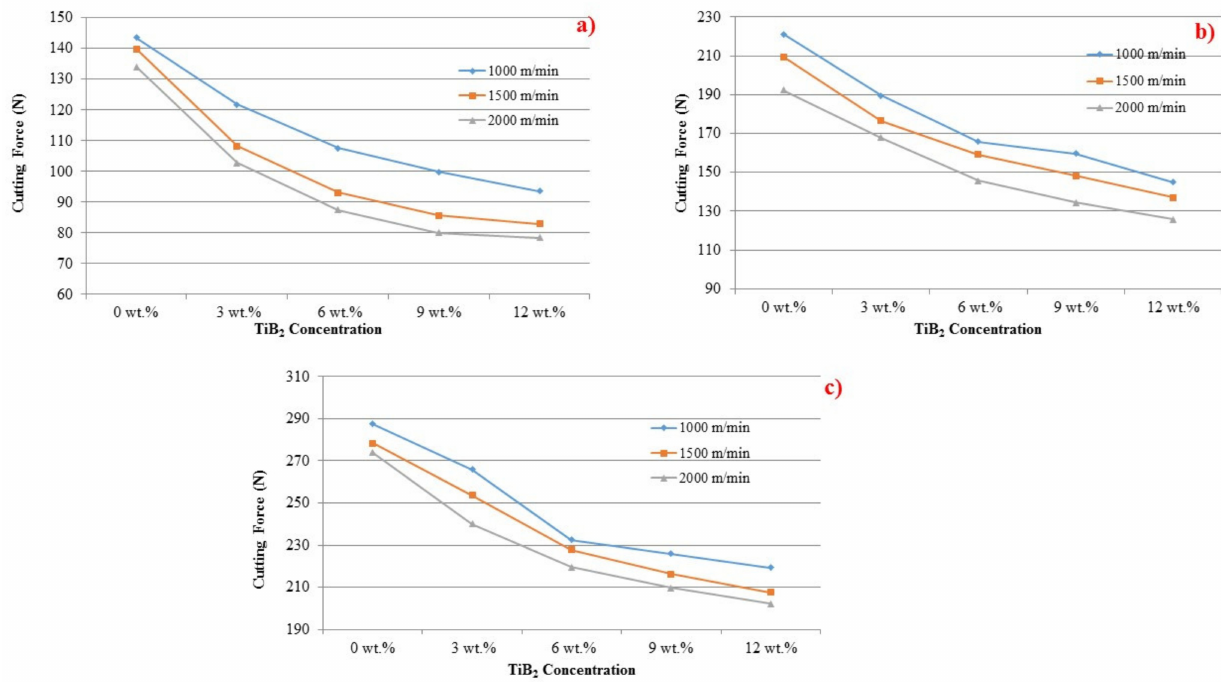
Figure 7. The effect of fillers on cutting force at various feed rate levels: ( a ) 0.5, ( b ) 1.0 and ( c ) 1.5